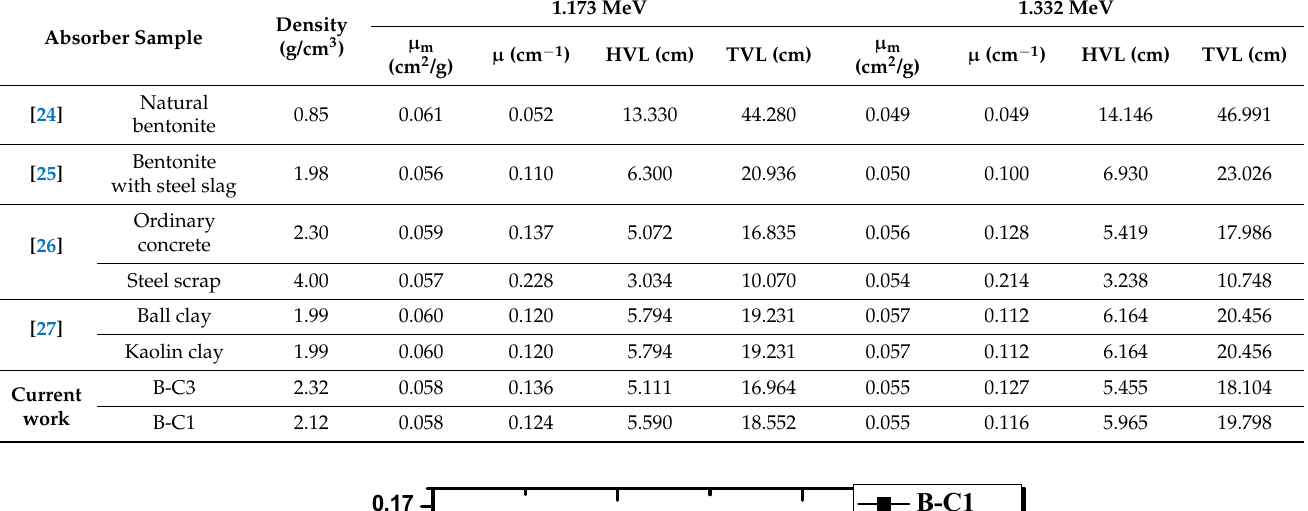
Table 4. Comparison of the shielding ability of the present samples against different studied materials.